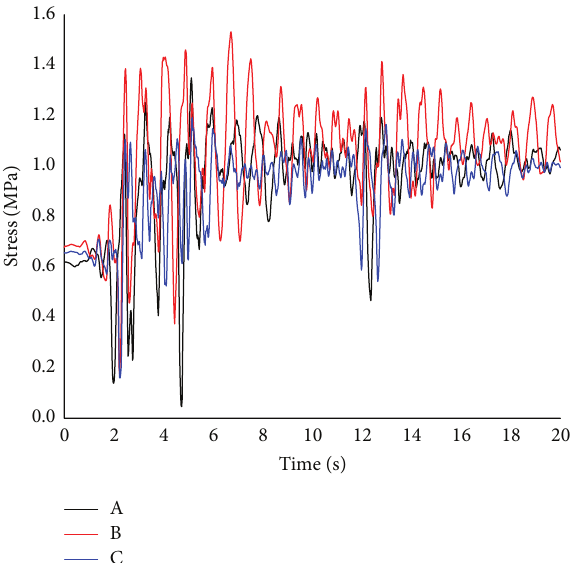
Figure 10: Maximum principal stress-time curves of monitoring points considering hydrodynamic pressure.